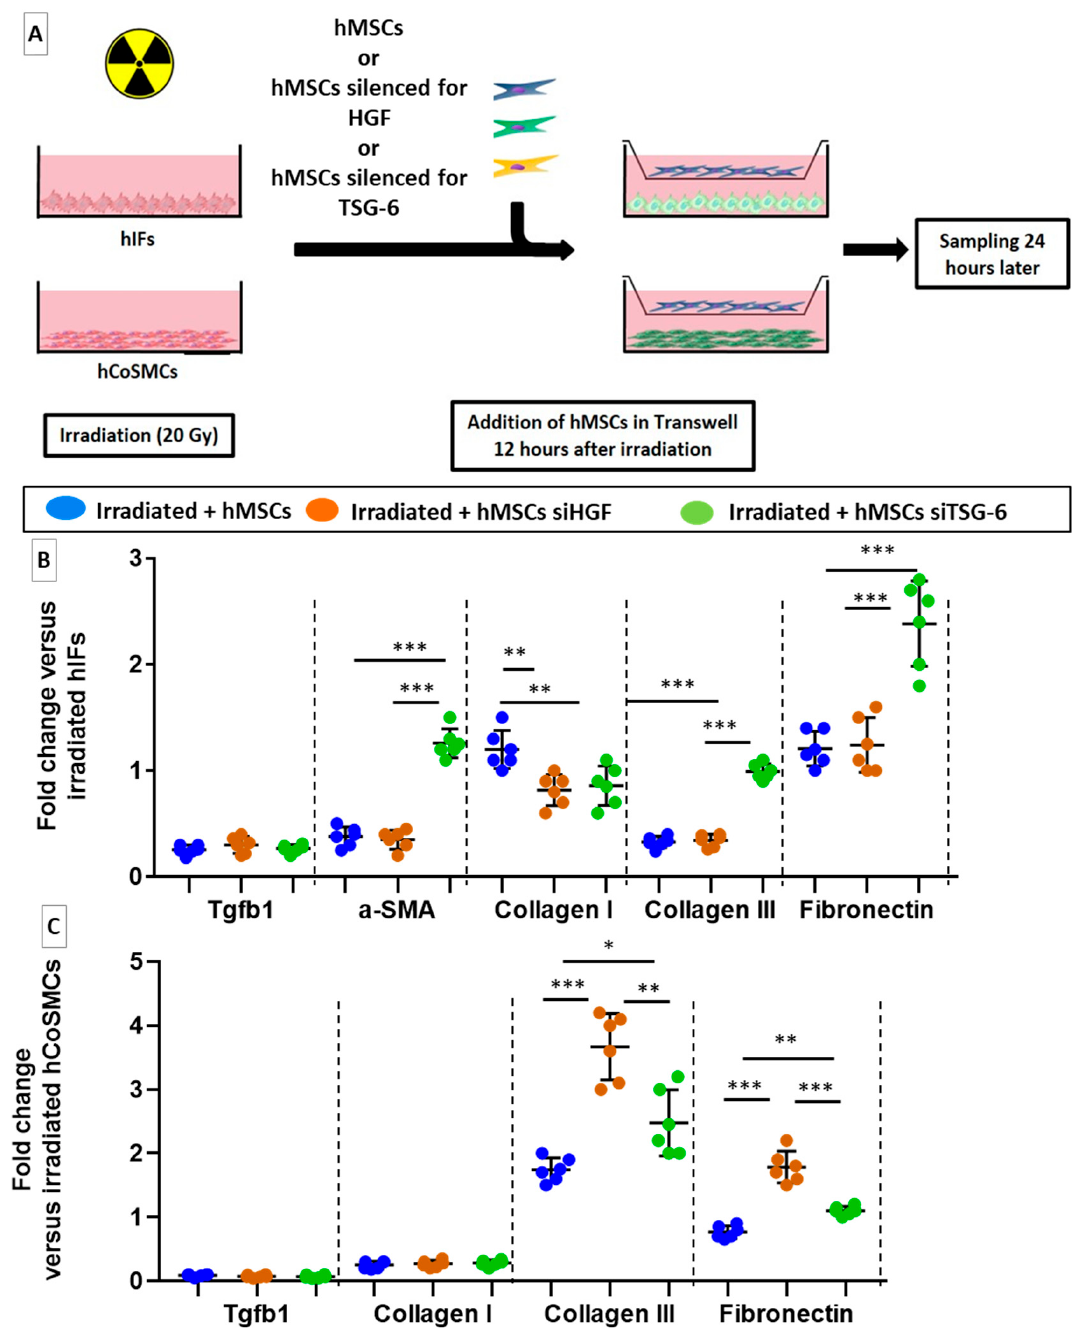
Figure 3. In vitro experiments show a direct effect of human MSCs and their effectors, HGF and TSG-6, on pro-fibrotic activity of irradiated hIFs and irradiated hCoSMCs. ( A ) hIFs and hCoSMCs were irradiated with a single dose of 20 Gy, and MSCs or MSCs silenced for HGF or TSG-6 were added to Transwell chambers 12 h after irradiation. ( B , C ) mRNA fold changes in fibrosis-related genes 24 h after MSC addition that are normalized to GAPDH and standardized against irradiated hIFs or irradiated hCoMSCs. ( B ) MSCs reduced common features of pro-fibrotic gene expression in irradiated hIFs and ( C ) irradiated hCoSMCs. ( B ) Silencing of TSG-6 in MSCs may counteract effect on α -SMA, collagen III and fibronectin expression in irradiated hIFs. ( C ) Silencing HGF in MSCs may counteract effect on collagen III and fibronectin expression in irradiated hCoSMCs. Two-group comparisons were performed with t -tests, while one-way ANOVAs, followed by Bonferroni t -tests, were used for multiple group comparisons. The results are expressed as mean ± SD. *: p < 0.05; **: p < 0.01; ***: p ≤ 0.001.